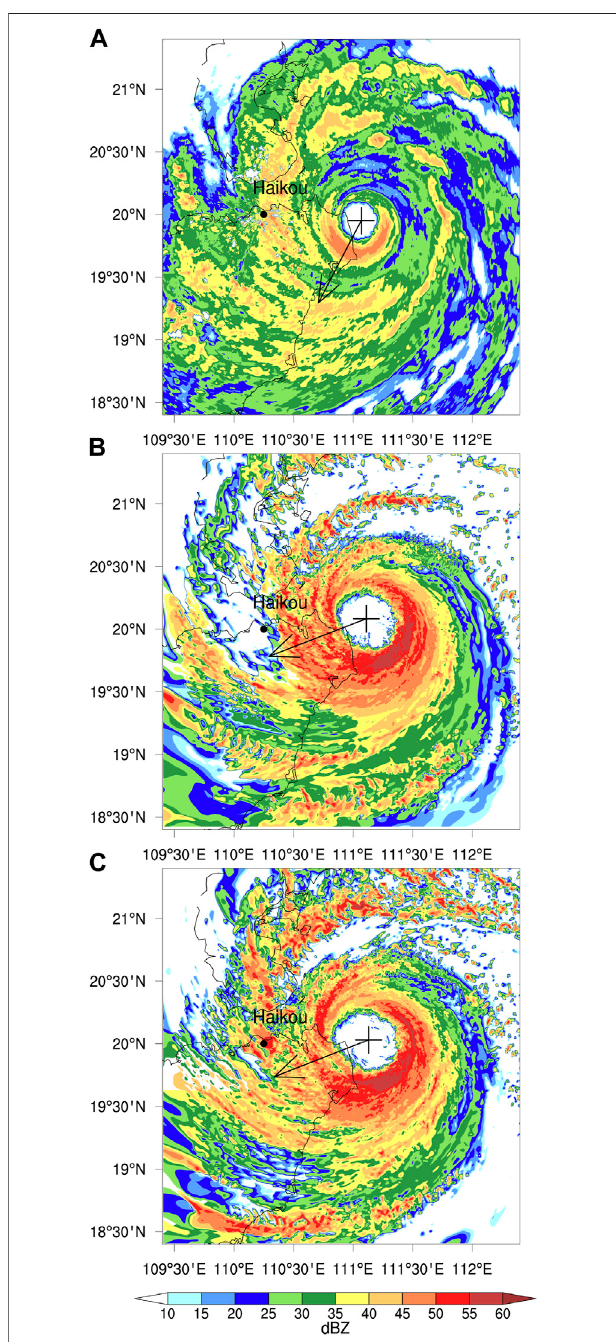
FIGURE2| Thecomparisonsoftheradarre fl ectivity(units:dBZ)from (A) Haikou station at 0659 UTC 18 July 2014 and the radar re fl ectivity at 800 m in (B) LES75and (C) LES151at 0700UTC18July2014intheD04domain. The arrow shows theverticalwind shear between200 hPaand 850 hPaand plus signs indicate the TC